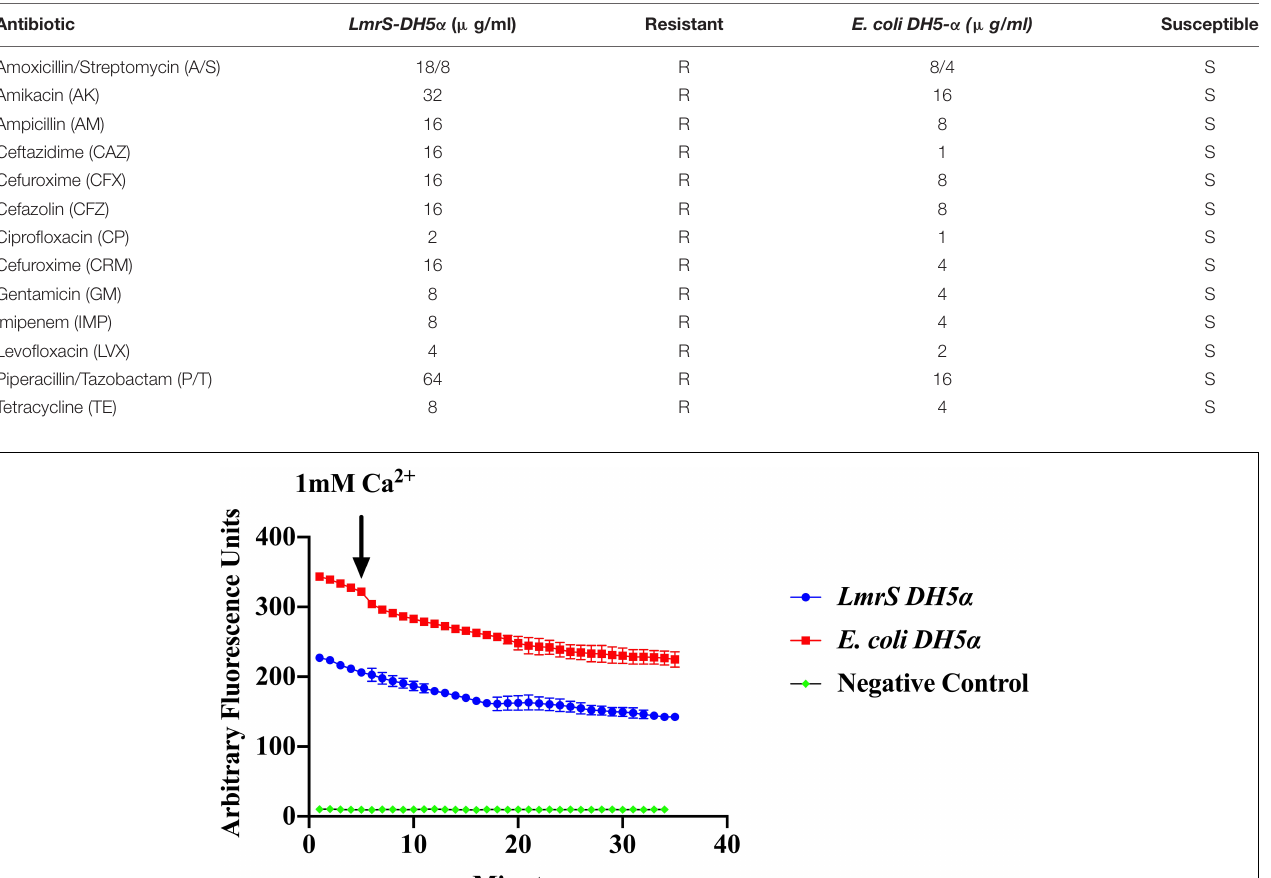
TABLE 2 | Minimum Inhibitory Concentrations (MIC) of cloned lmrS vs. control cells. Antibiotic Resistant E. coli DH5- α ( µ g/ml) Susceptible